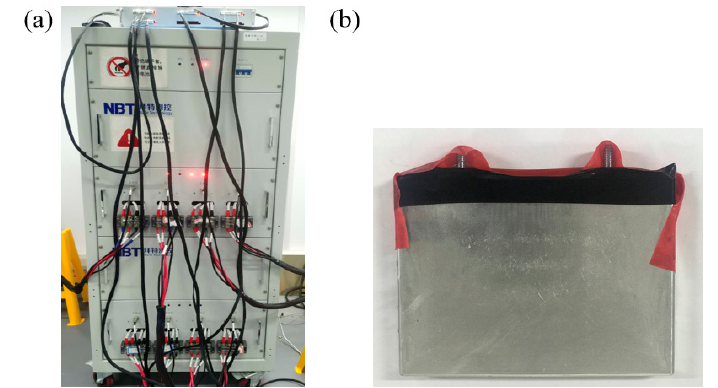
Figure 3. Experimental equipment and subject: ( a ) Ningbo Bate Technology (NBT) test bench (Ningbo Bate Technology Co., LTD, Ningbo, China); ( b ) NCM LIB battery.